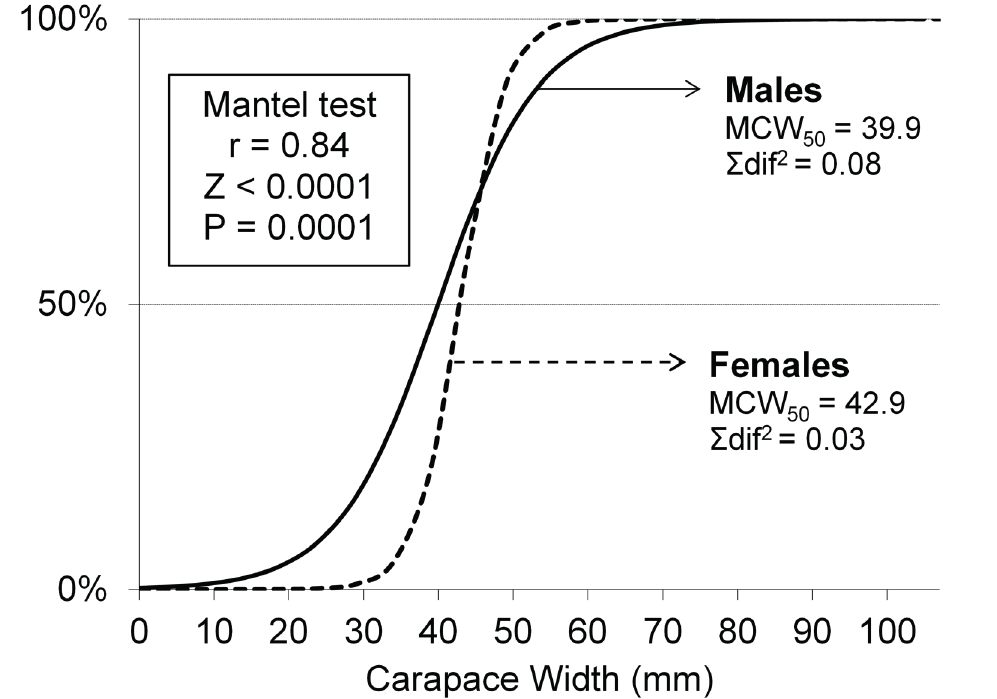
Figure 5 . Adjustment of the logistic equation indicating the maximum carapace width (MCW) for males and females of the swimming crab Achelous spinimanus , in which 50% of the crabs are mature according to the analyses of gonadal development. The result of the Mantel test refers to the comparative matrices (frequency per size class of adult and immature females vs. adult and immature males) and the similarity between them (Legendre et al .,